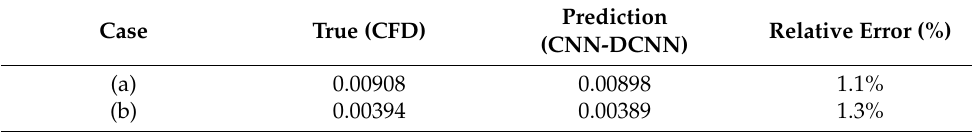
Table 6. Drag coefficients for two cases in Figure